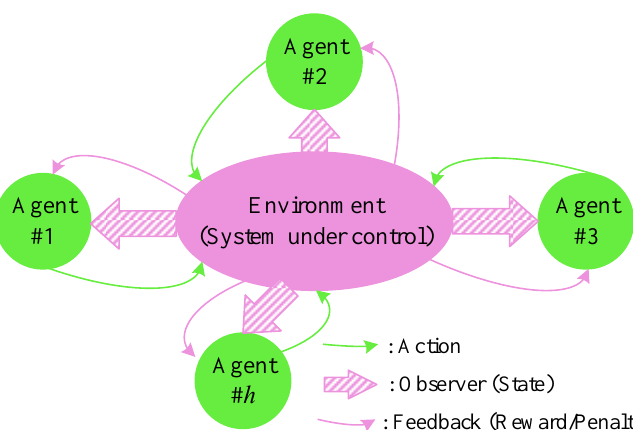
Figure 1. Multi-agent system (MAS) reinforcement learning procedure with N intelligent